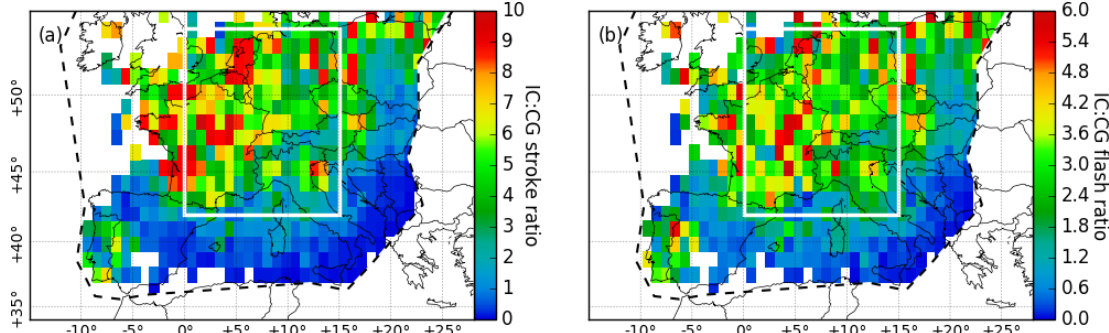
Figure 3. IC:CG (a) stroke and (b) flash ratio within the EUCLID domain (dashed) and cut off at 54 ◦ according to the ISS-LIS maximum latitudinal coverage. The rectangle highlighted in white is the area with the highest IC:CG ratio and is referred to as the center of the EUCLID network throughout the paper.